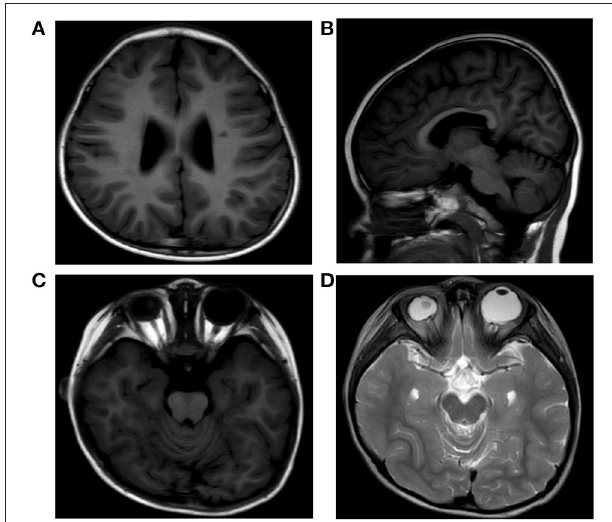
FIGURE 2 | MRI of the patient’s brain showing dilation of bilateral ventricles, a small patchy abnormal signal in paraventricular white matter (A) , hypogenesis of corpus callosum (B) , small right eye, and abnormal shape and signal of the lens (C,D)